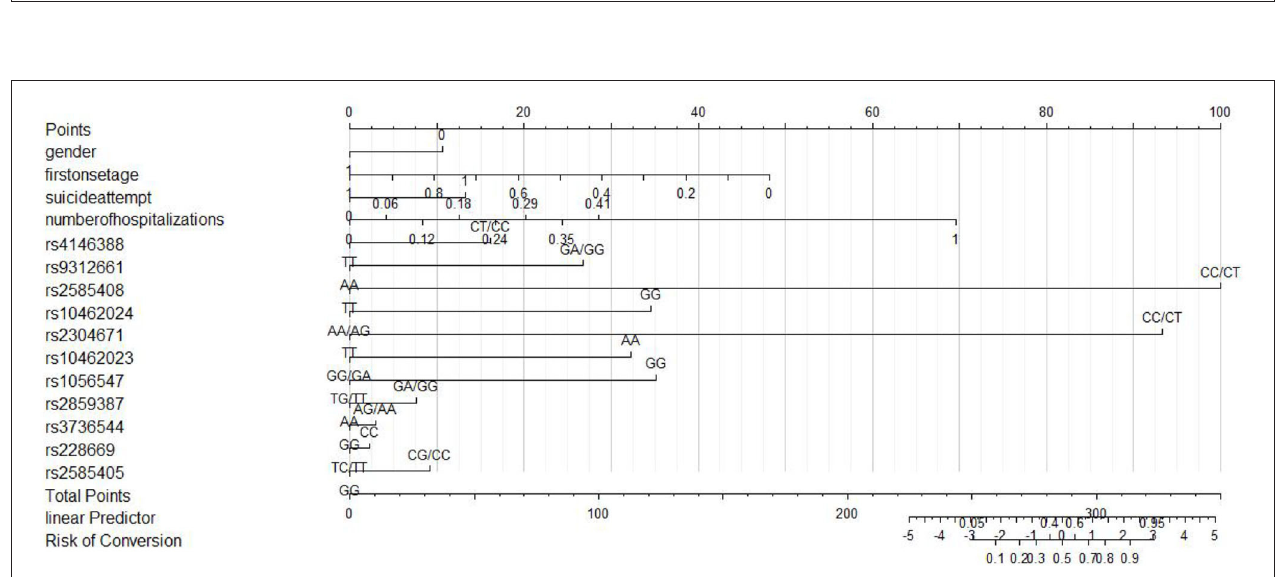
FIGURE 6 | Nomogram for predicting risk of bipolar